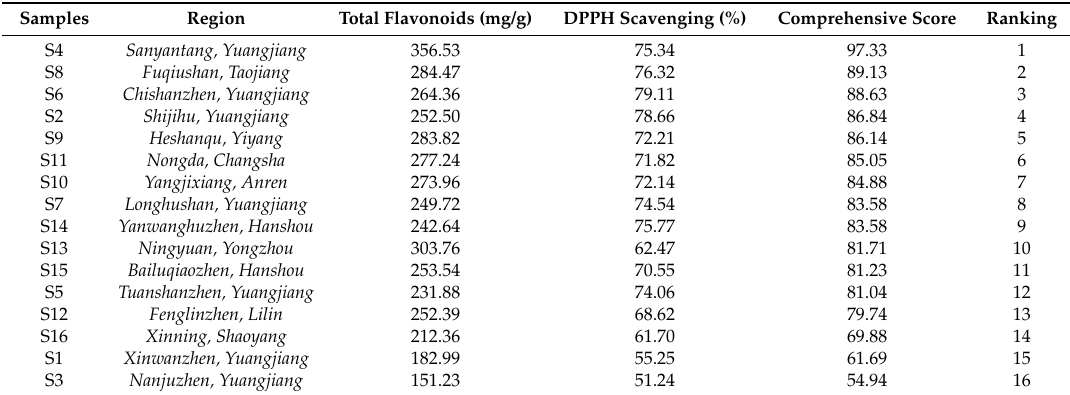
Table 5. Comprehensive evaluation of Aurantii fructus from different areas in Hunan Province based on the intercriteria correlation (CRITIC) method ( n =